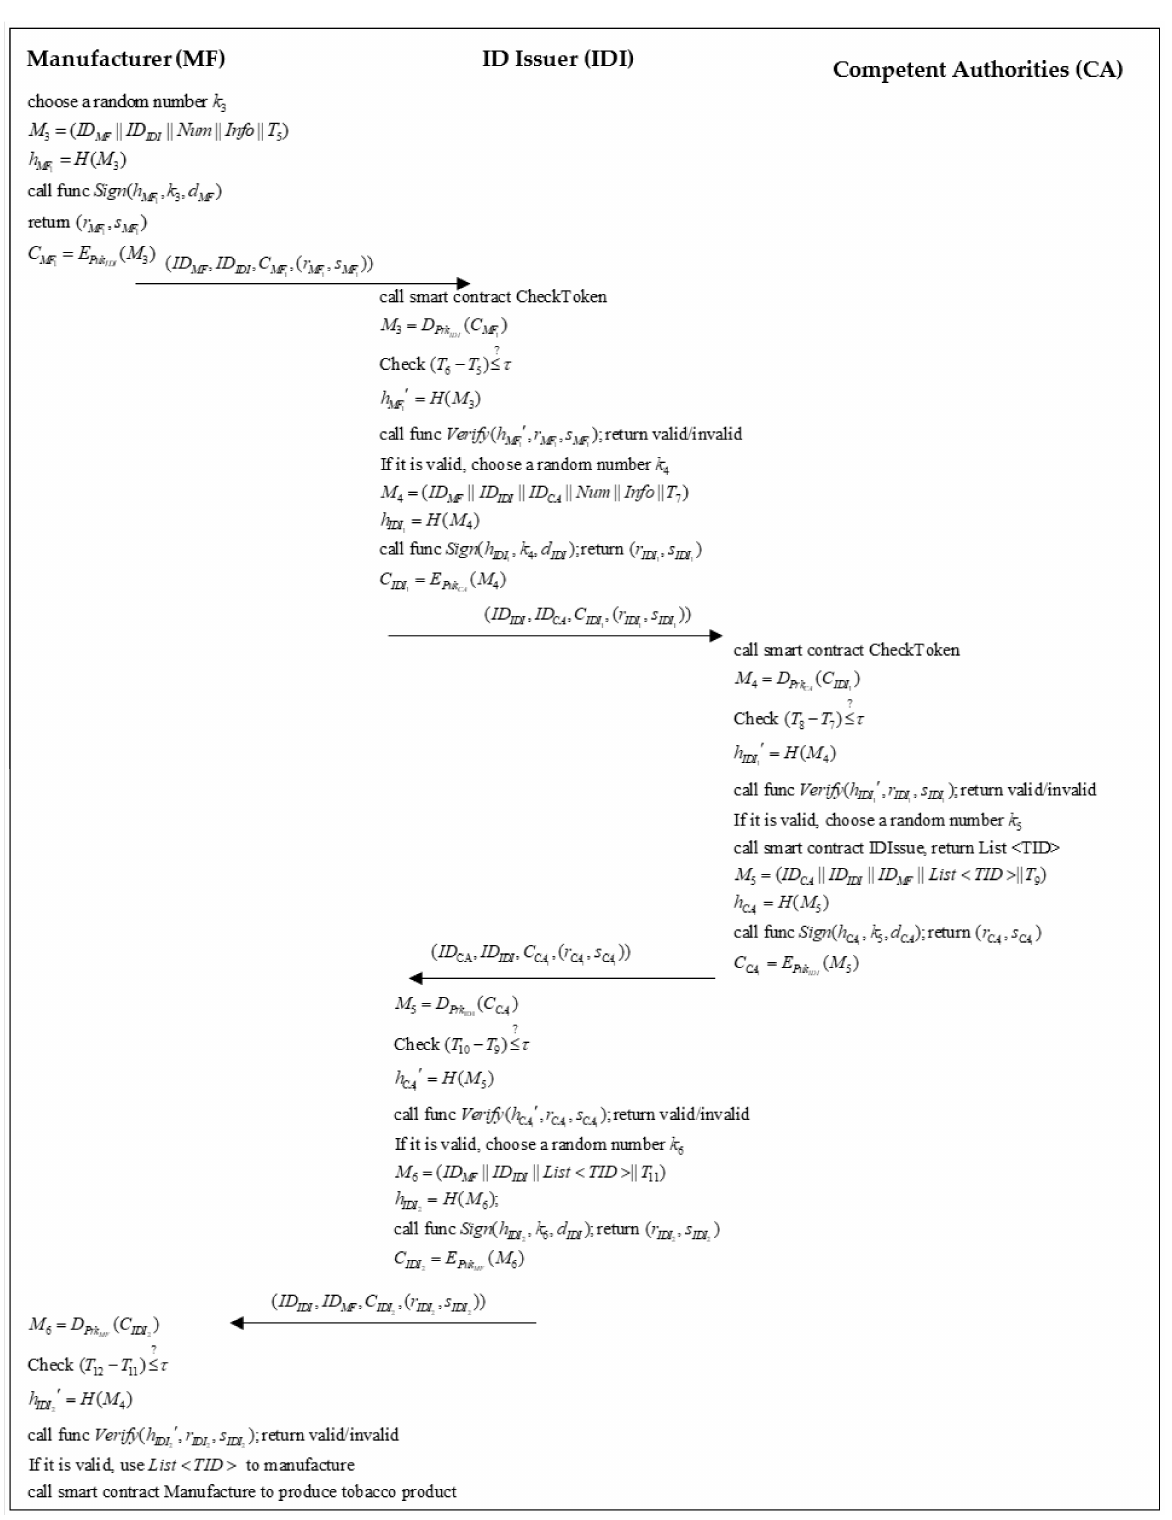
Figure 8. The flowchart of the issuing ID and manufacture